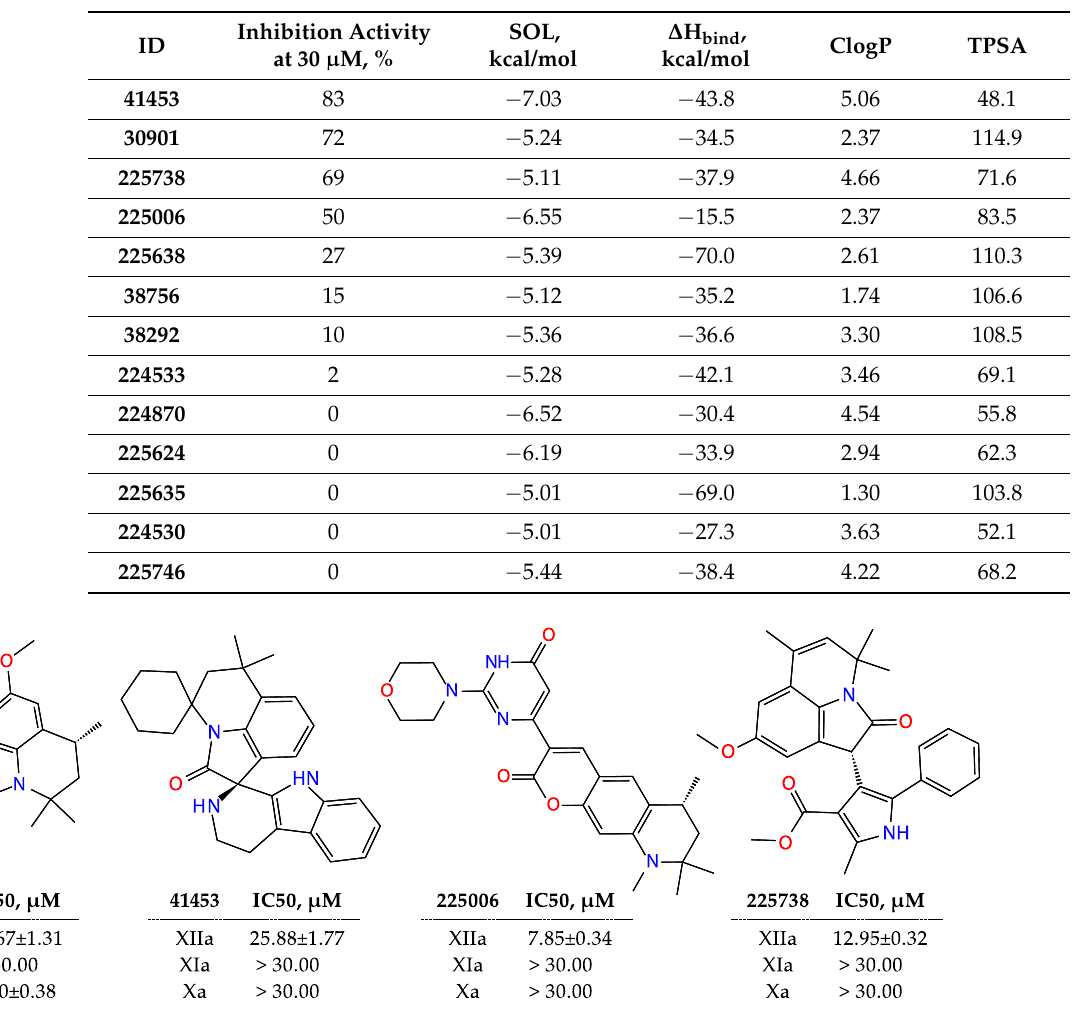
Figure 5. Structures of four identified inhibitors of the coagulation factor XIIa. IC 50 values are shown for three coagulation factors: Xa, XIa, and XIIa. For compounds which did not show any activity against off-target at 30 µ M, IC 50 was not measured. So, they are marked with ‘>30’ in a column with activity